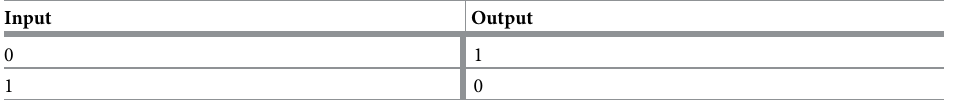
Table 2. Truth table of NOT gate.